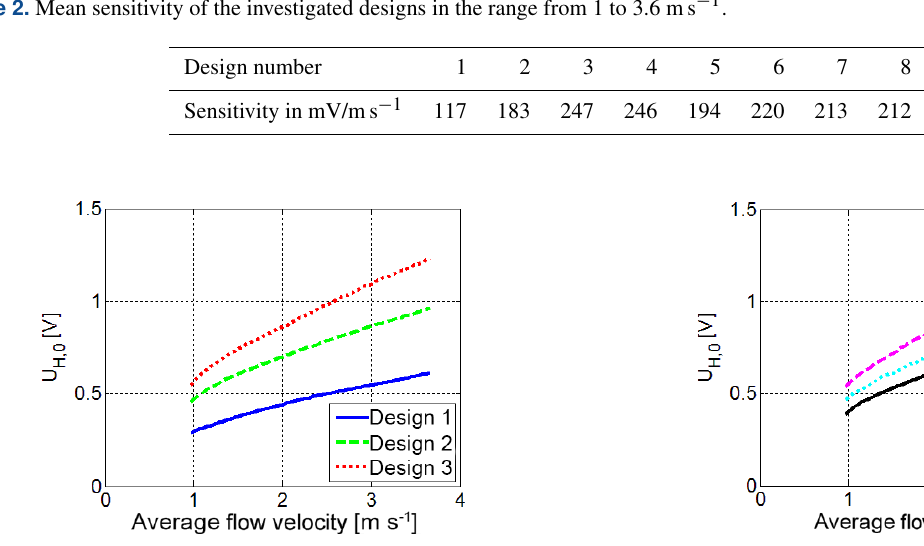
Figure 9. Comparison of the output characteristic of three different transducer designs (calorimetric approach) where the gap between the copper leads was varied. The gap widths for designs 1–3 amount to 100, 200, and 300µm, respectively.